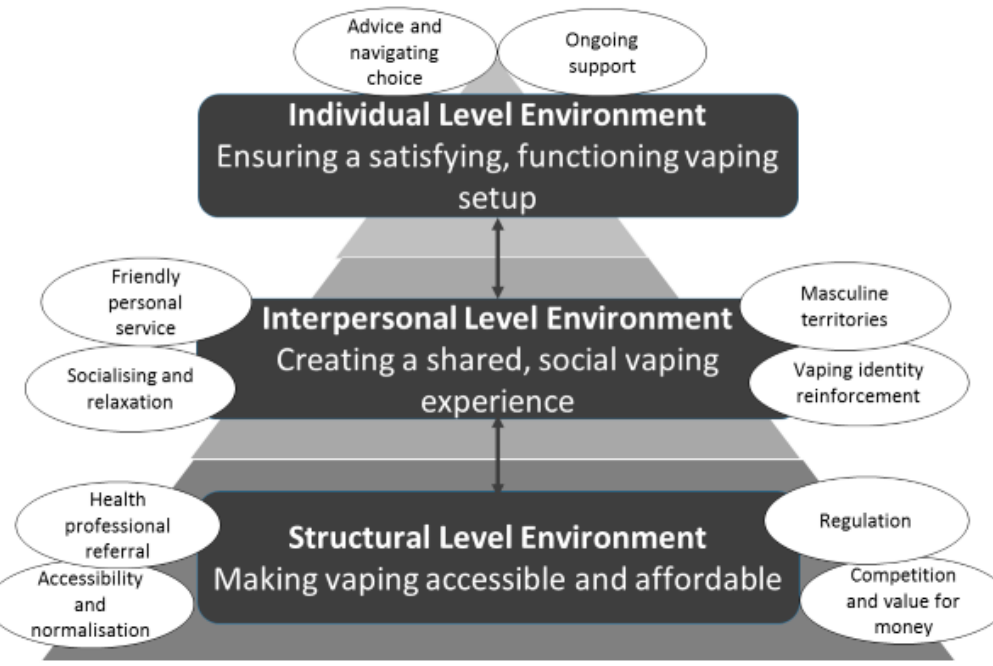
Figure 1. Thematic structure relating to the role the vape shop environment has in supporting smoking abstinence.